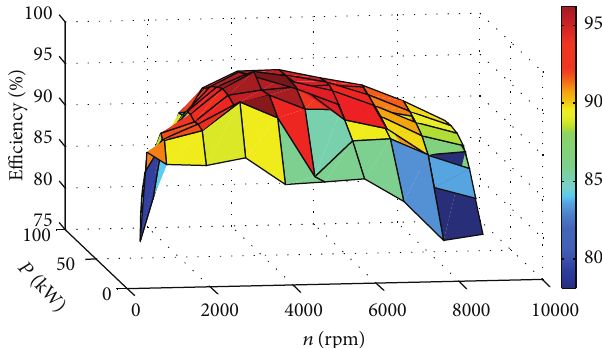
Figure 4: The efficiency map of the